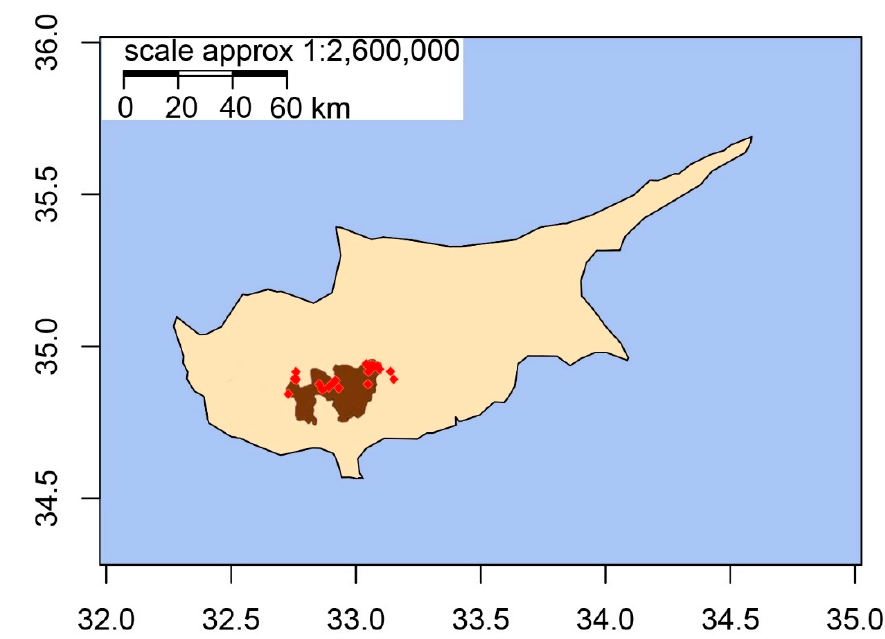
Figure 1. Map of Cyprus. Shaded area (brown) indicates the Commandaria zone and red rhombi mark the collection sites.